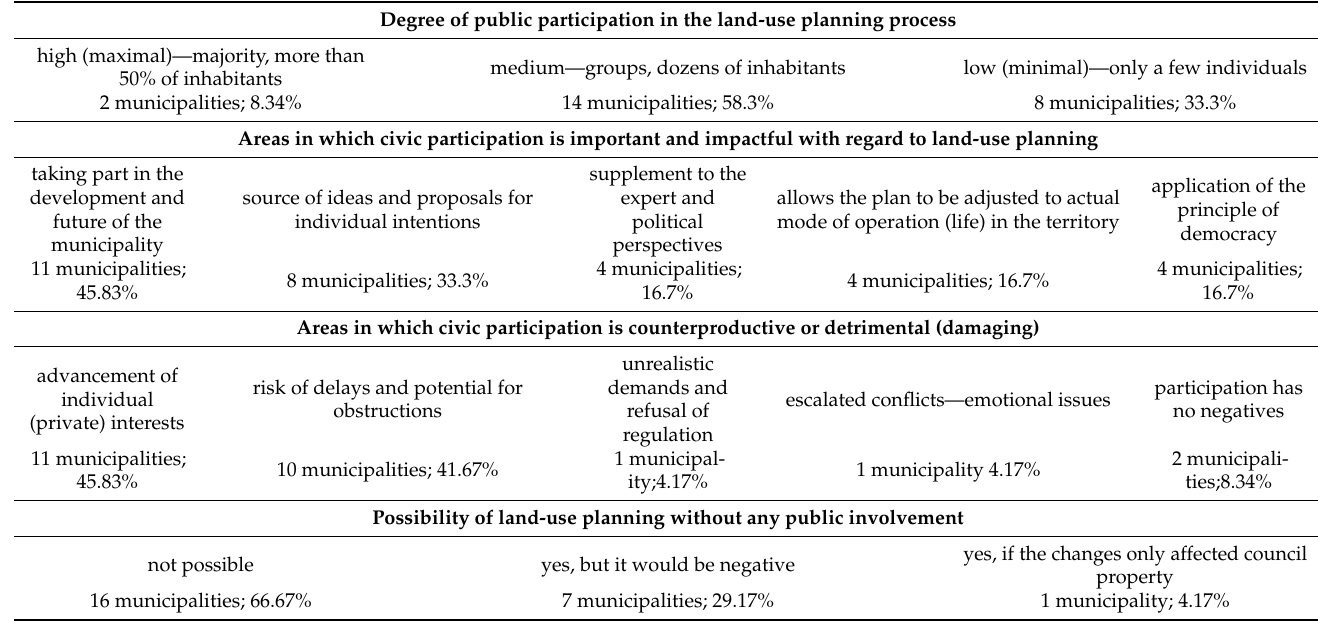
Table 2. Quantified categorization of responses to the four main research